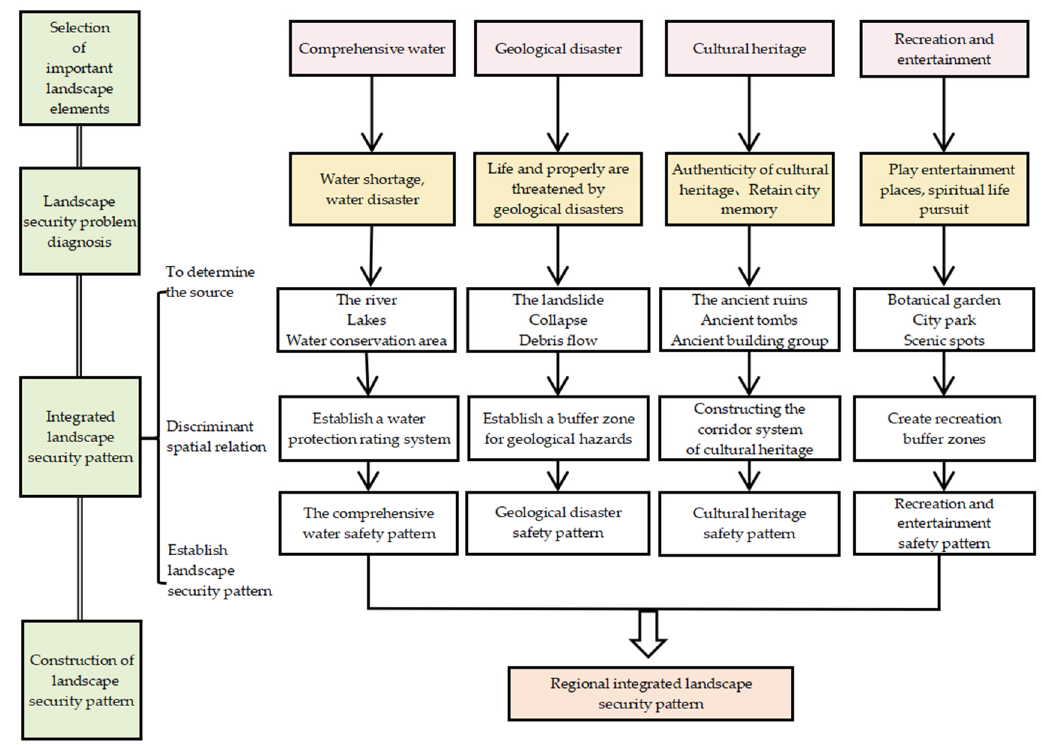
Figure 1. Construction framework of integrated landscape security pattern.